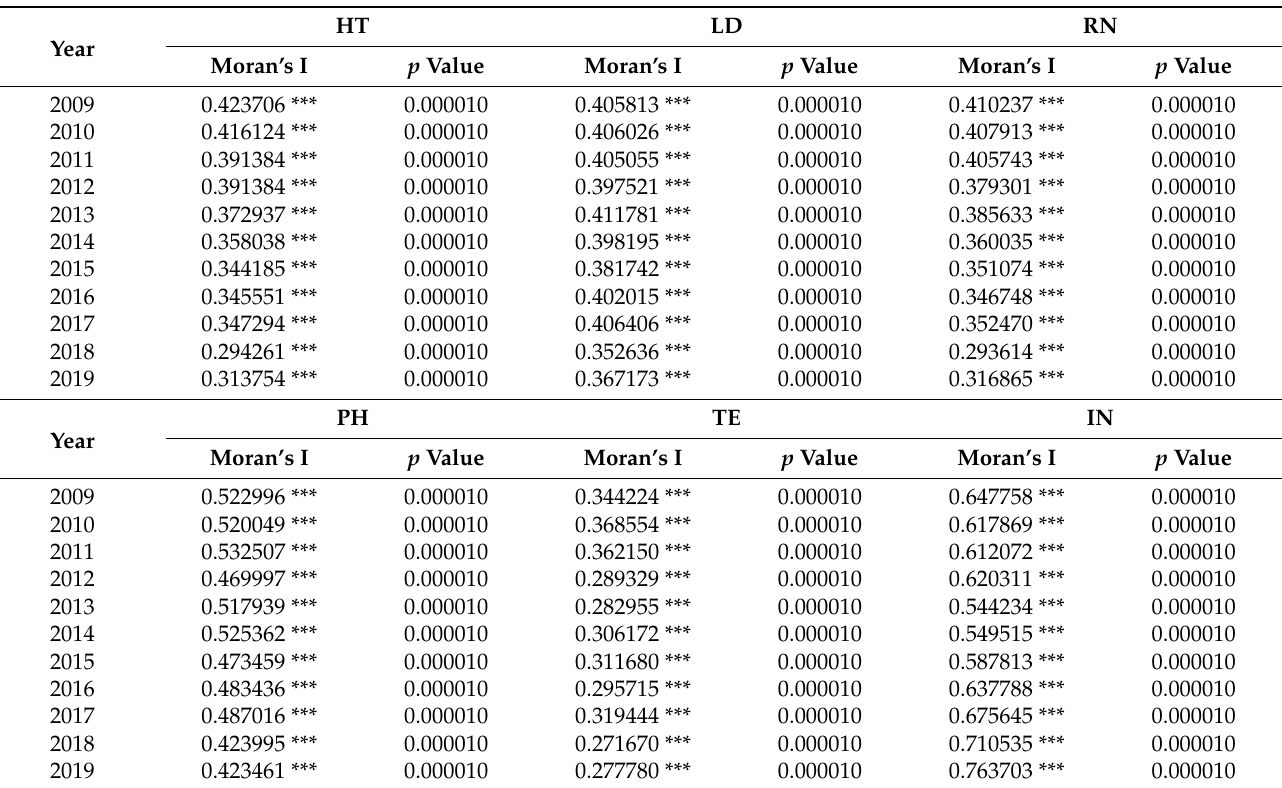
Table 1. Global spatial autocorrelation analysis and significance test results of the number of healthcare professionals per 1000